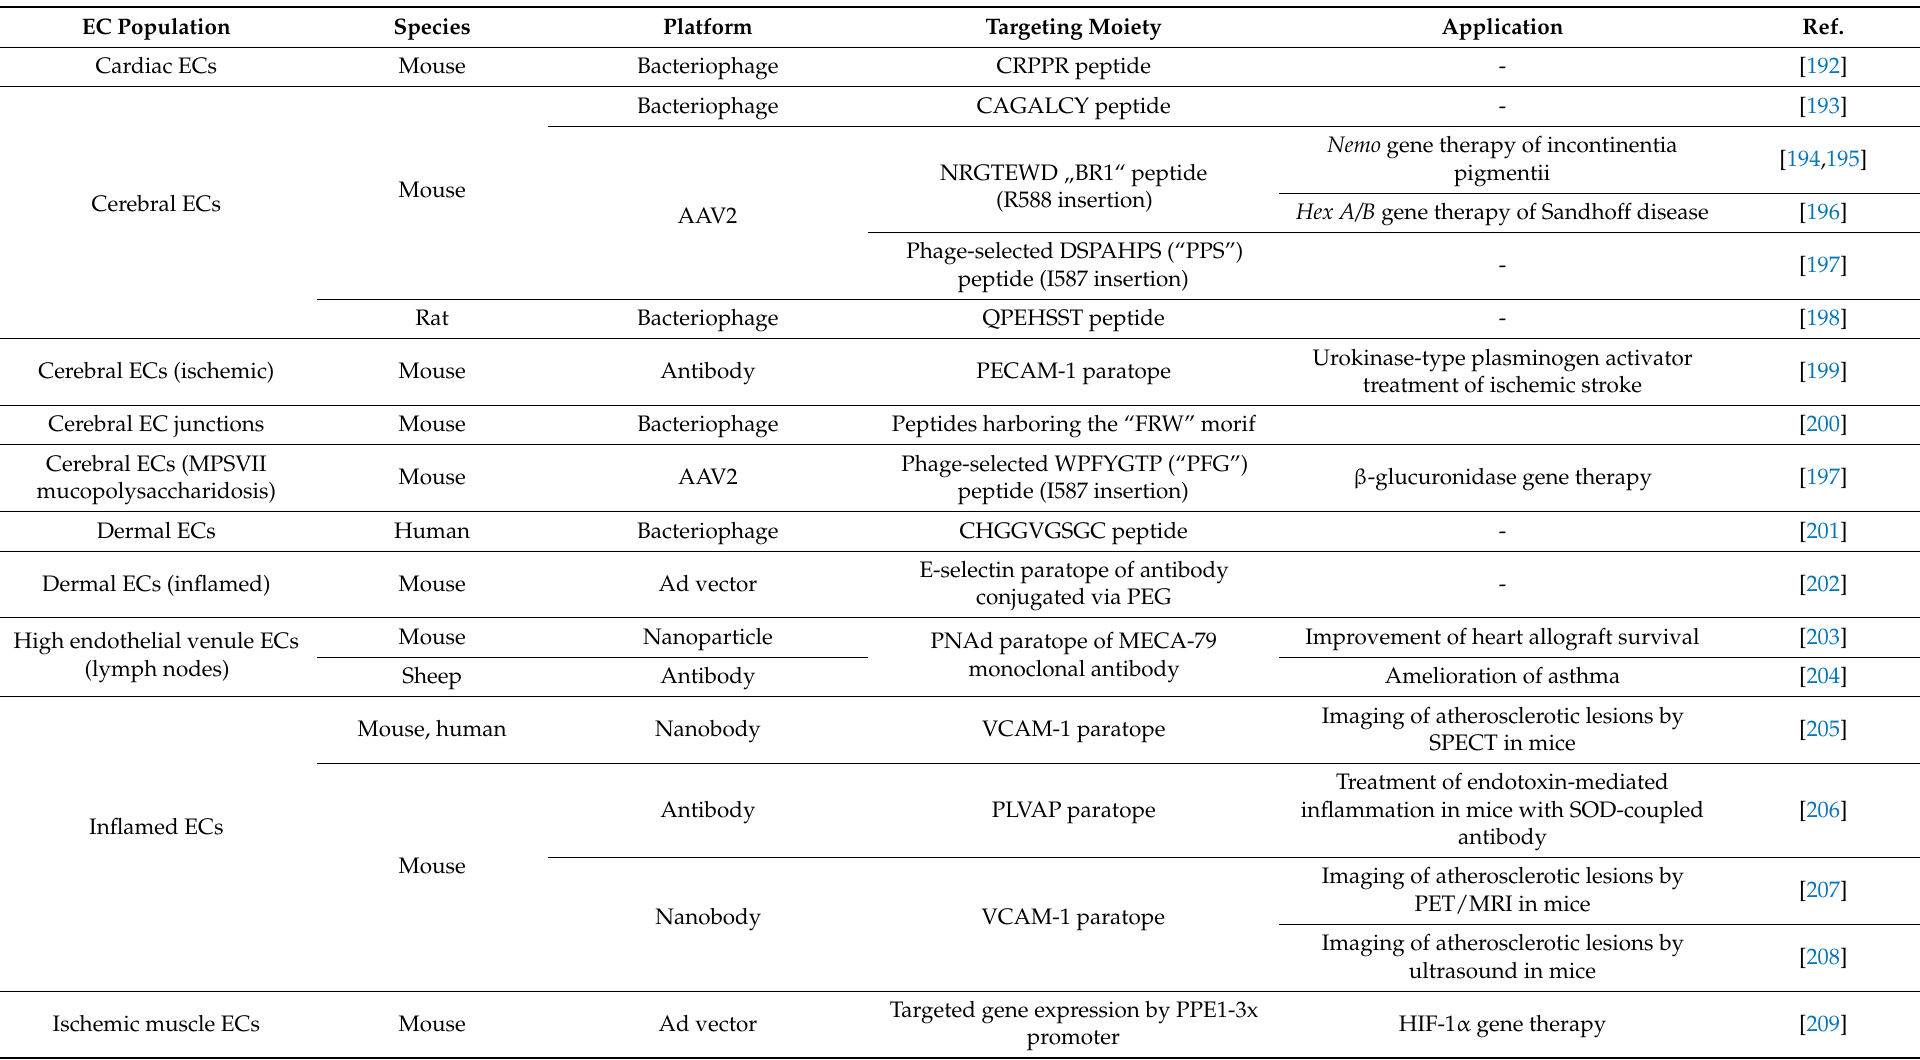
Table 1. Examples of selective EC